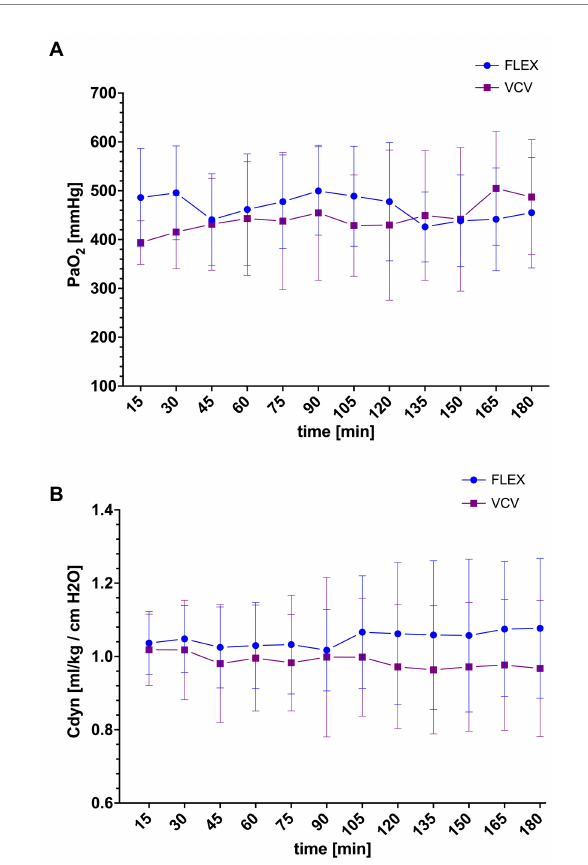
FIGURE 2 Mean and SD of the arterial partial pressure of oxygen (PaO 2 ) (A) and weight-corrected dynamic compliance (C dyn ) (B) in horses ventilated either with conventional volume-controlled ventilation (VCV, purple square) or with flow-limited exhalation ventilation (FLEX, blue circle) after PEEP-titration alveolar recruitment. T15 corresponds to T15 of Figure 1 and Table